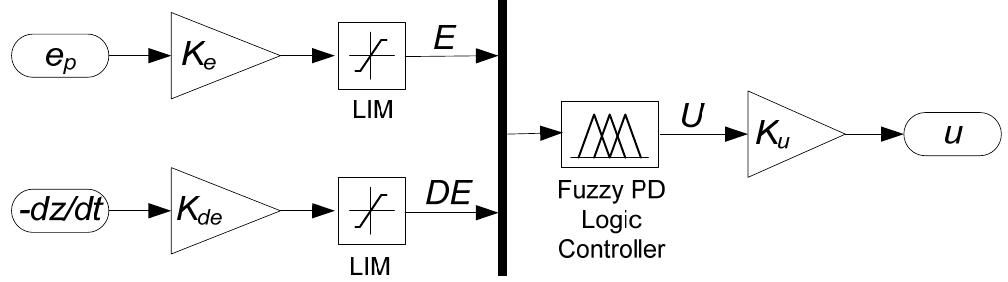
Figure 3. Fuzzy PD logic controller setup.